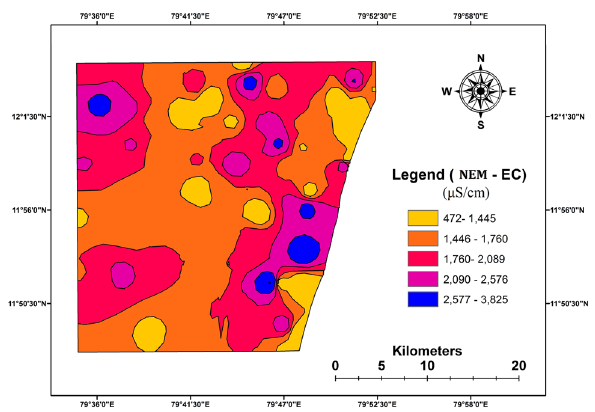
Fig. 6 Spatial distribution of EC (µS/cm) for groundwater samples collected during NEM